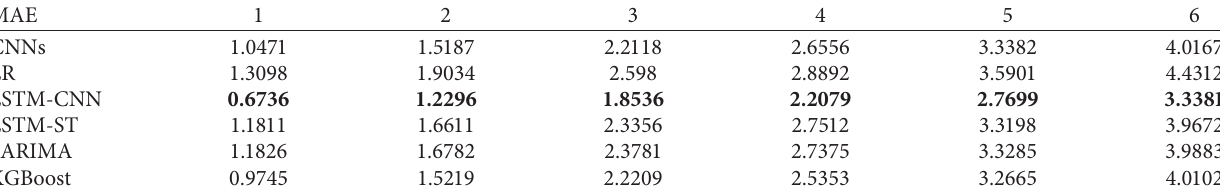
Table 4: MAE comparison of multistep prediction.